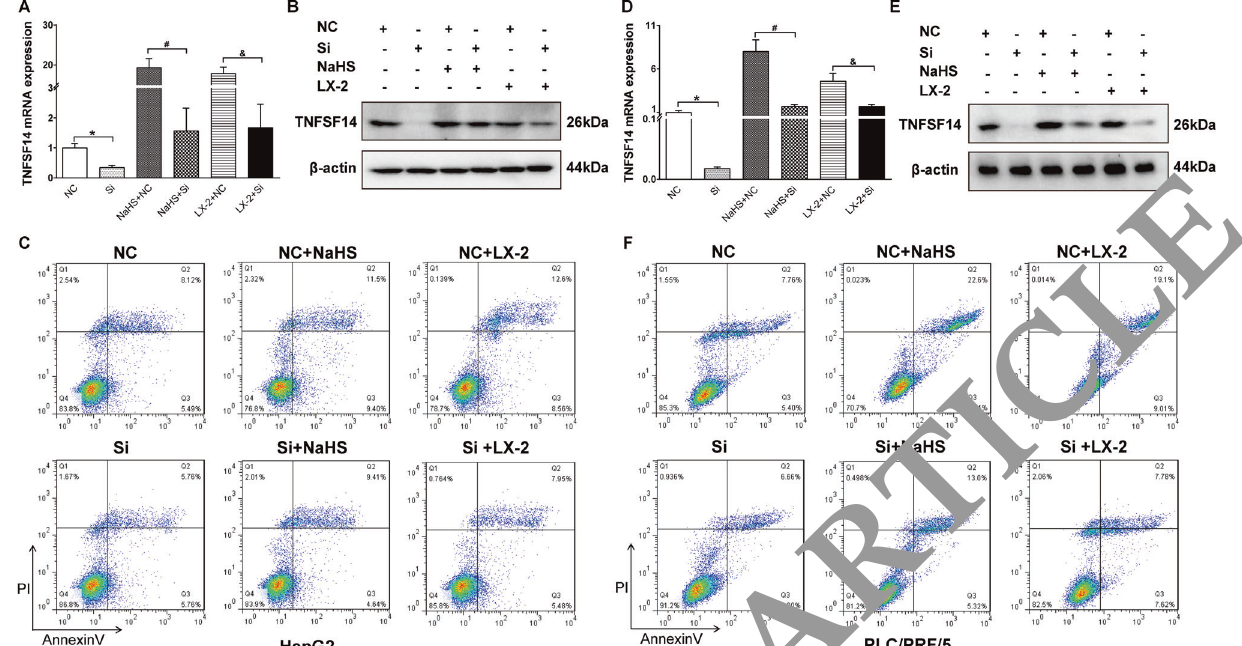
Fig. 4 TNFSF14 is indispensable for H 2 S-induced HCC cell apoptosis. TNFSF14 mRNA and protein expressions levels were evaluated by ( A , D ) RT-qPCR and ( B , E ) Western blotting assays in HepG2 and PLC/PRF/5 cells under different treatments. Flow cytometry was carried out to analyze the effects of different TNFSF14 expression levels on HepG2 ( C ) and PLC/PRF/5 ( F ) cells apoptosis. All Bars, ± SD; n = 3; * P < 0.05 compared with NC group, # P < 0.05 compared with NC + NaHS group, & P < 0.05 compared with NC + LX-2